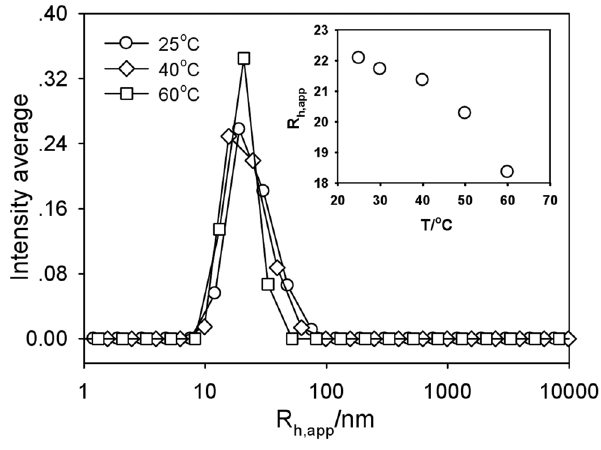
Figure 5. Temperature effect on hydrodynamic radius of plasmid DNA in 95% DMF at 30 u . The inset shows the temperature dependence of R h,app at zero angle. doi:10.1371/journal.pone.0013308.g005 PLoS ONE |